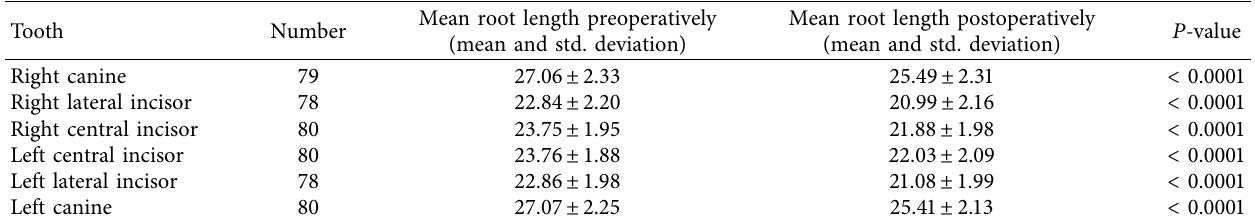
Table 1: Mean root length of maxillary anterior teeth before and after orthodontic treatment (mm). Tooth